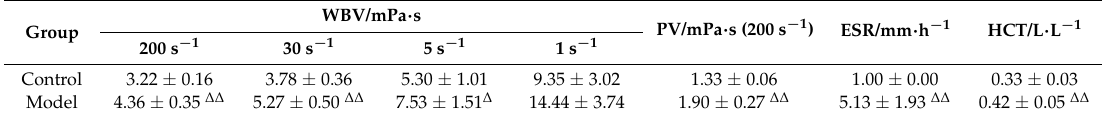
Table 1. The haemorheological indices of normal and blood stasis